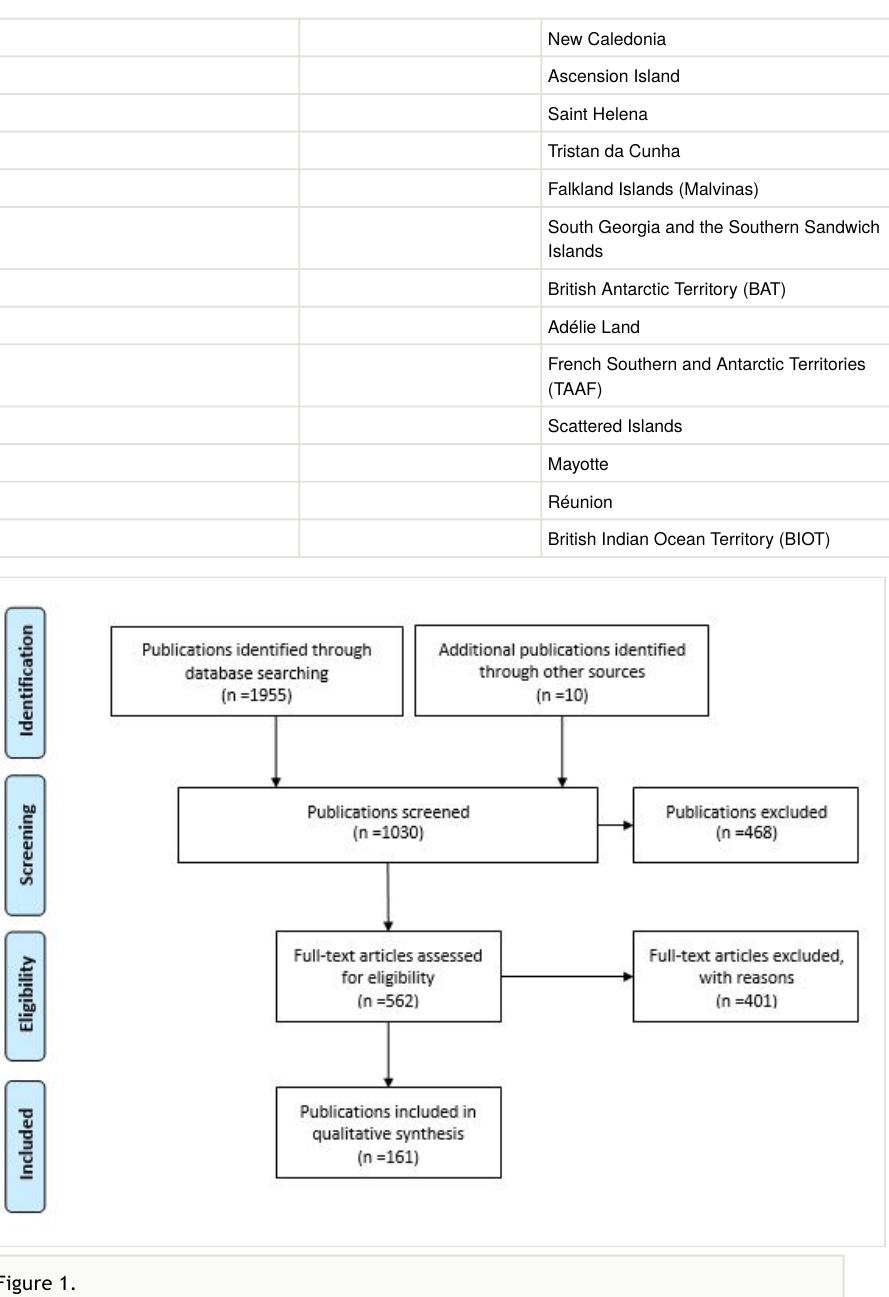
Figure 1. Flow diagram of the methodology and selection processes used in this systematic review, following the rules and templates of PRISMA (Preferred Reporting Items for Systematic Review (Moher